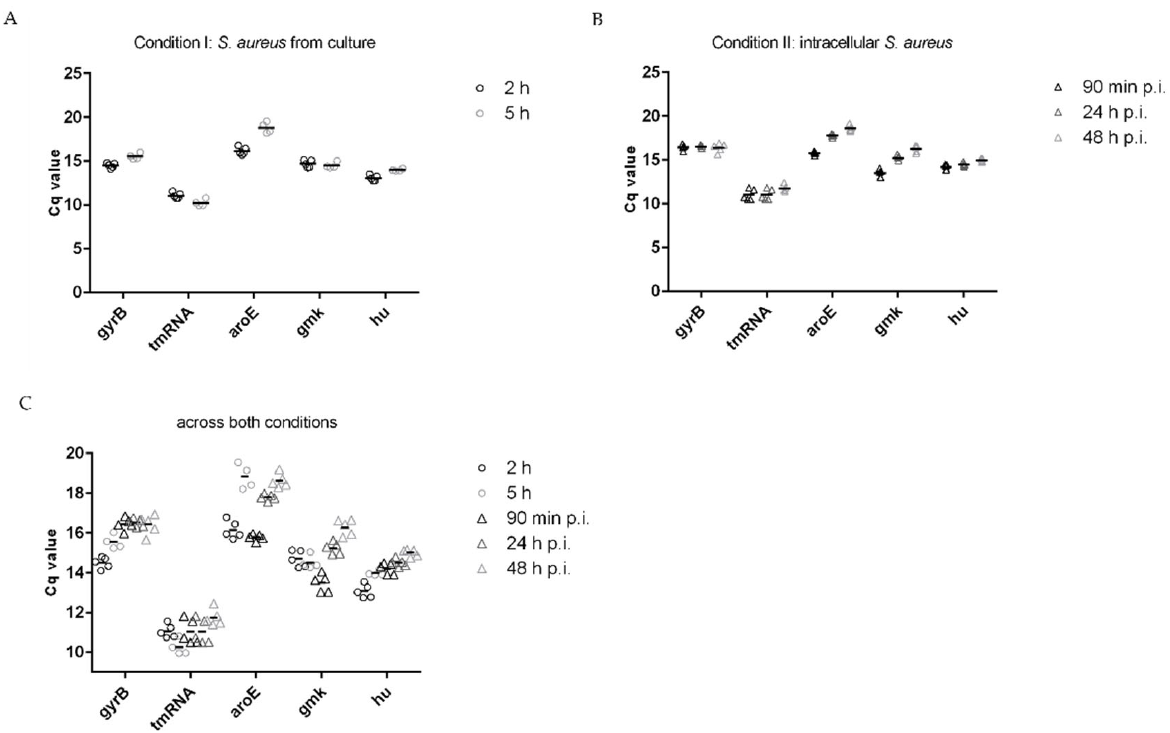
Figure 4. Variability of C q values of candidate housekeeping genes for ( A ) S. aureus from culture after 2 h and 5 h of incubation (condition I), ( B ) intracellular S. aureus at 90 min, 24 h, and 48 h postinfection (condition II), and ( C ) across conditions I and II. Bars indicate the mean of at least four independent experiments.